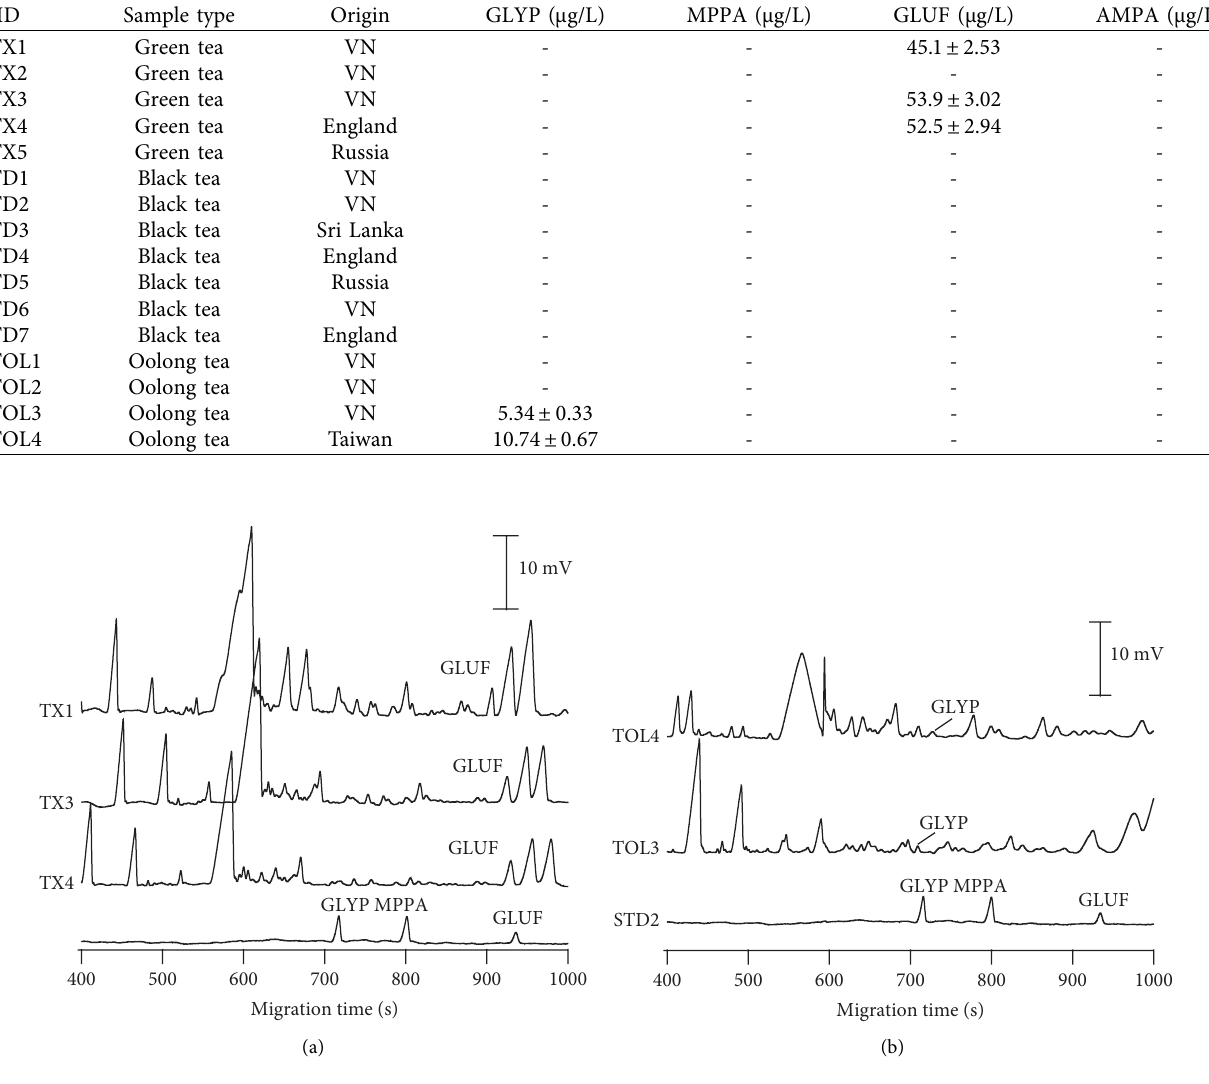
Figure 4: Electropherograms of the green (a) and oolong (b) tea infusion samples. Other CE conditions as in Figure 1 and Figure 2,